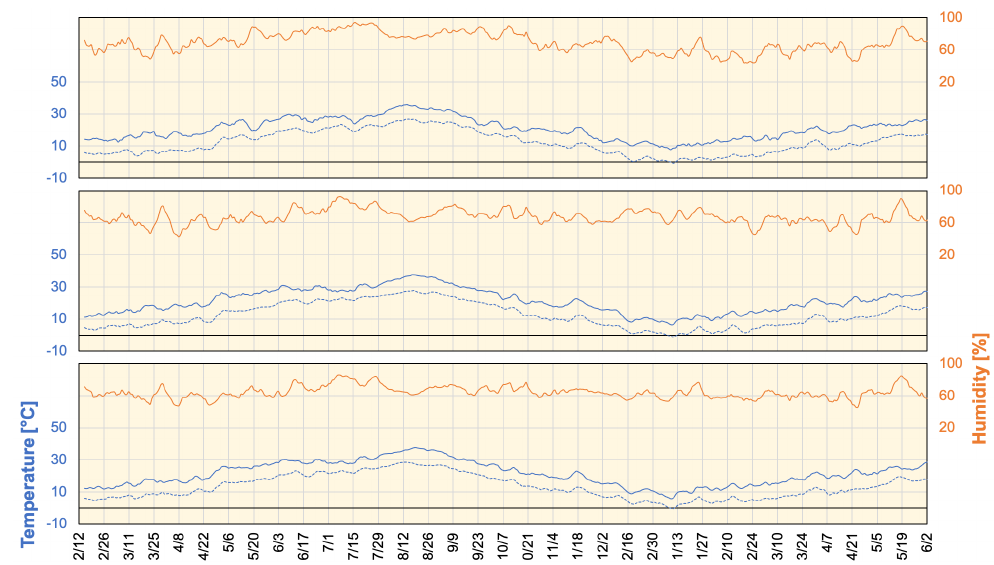
Figure 2. Maximum/Minimum daily temperature and average humidity for Tokyo, Nagoya, and Osaka (from top to bottom) from 19 February 2020 to 2 June 2021. Lines represent a 7-day average. Table 1. Dataset splitting for training and testing in different forecasting time